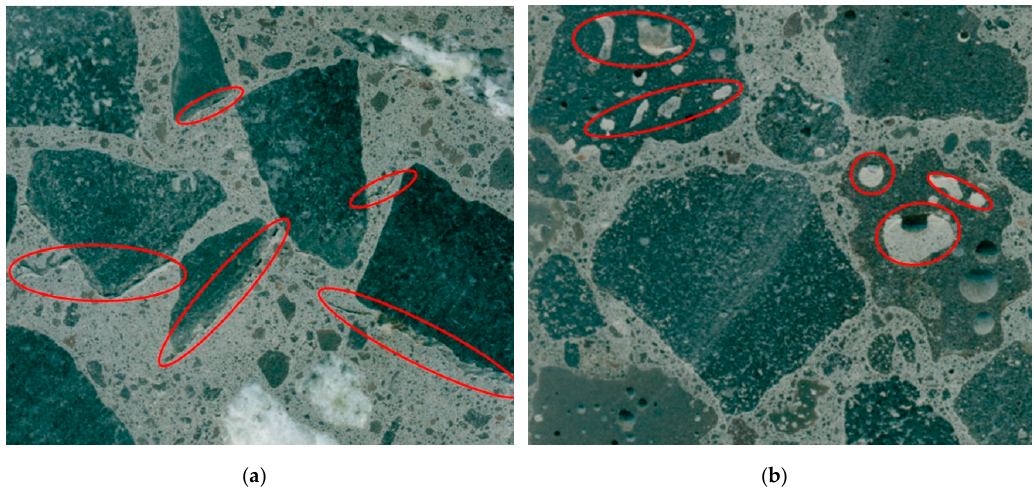
Figure 2. Microstructure of concrete: ( a ) Normal concrete; ( b ) High titanium slag concrete.